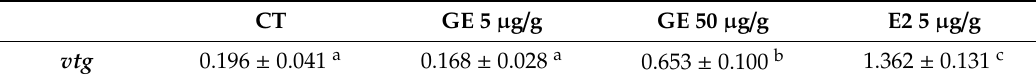
Table 2. Gene expression of hepatic vitellogenin ( vtg ) in rainbow trout intraperitoneally injected with genistein (GE) or 17 β -estradiol